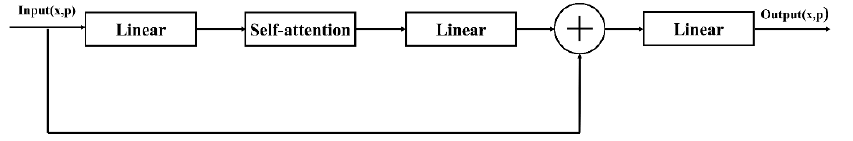
Figure 4. The detailed structure design of the self-attention module. The linear box represents a two-layer MLP. The Self-attention box represents the modified self-attention layer.